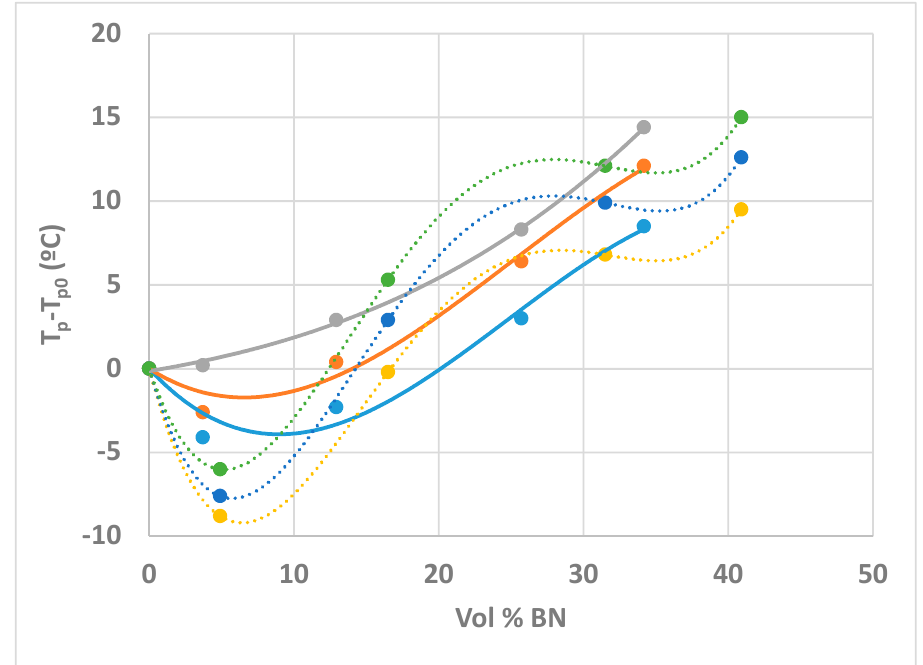
Figure 8. Plot of T p − T p0 as a function of vol % BN for the systems ETLBN80 and ETLBN80/6, respectively, at the heating rates of 2 (dark blue, purple), 5 (red, light blue), and 10 K/min (green, orange). The curves are drawn to guide the eye: full lines for ETLBN80, dotted lines for ETLBN80/6.